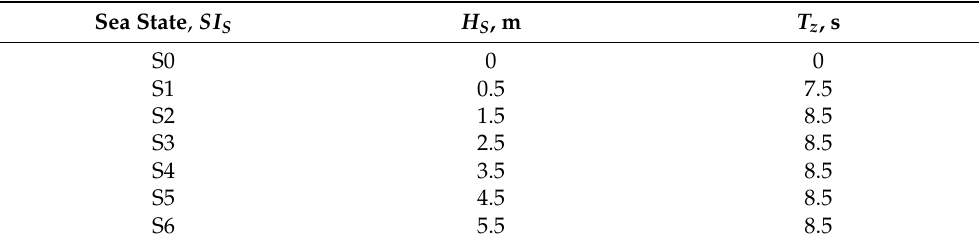
Figure 2. Areas for the investigated Shanghai–Hamburg sailing route [28]. Table 2. Sea